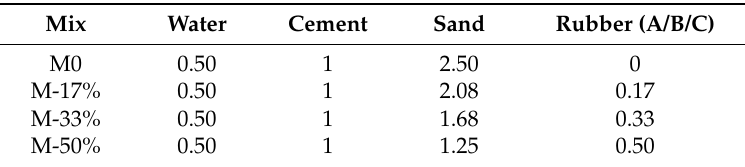
Table 3. Mortar mixture proportions (by weight).